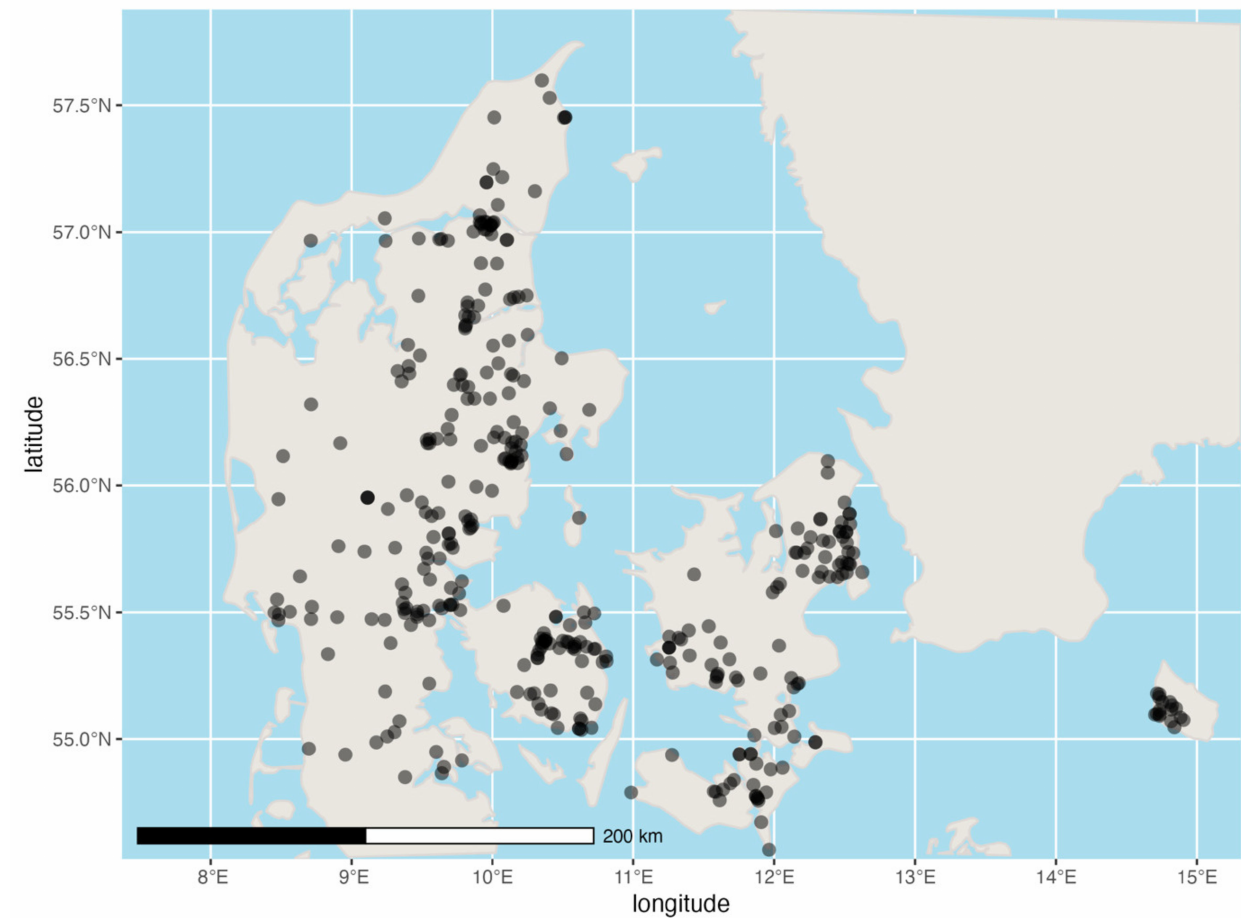
Figure 1. The distribution of the 369 geolocated samples collected during the study. Each point represents a single sample. Points are opaque and thus multiple samples from the same or nearby locations result in darker